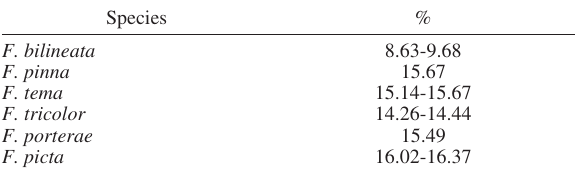
Table 3. – Minimum and maximum and COI gene pairwise uncor- rected p -distances between F. aurantimaculatata n. sp. and the remaining species of the genus Felimare .